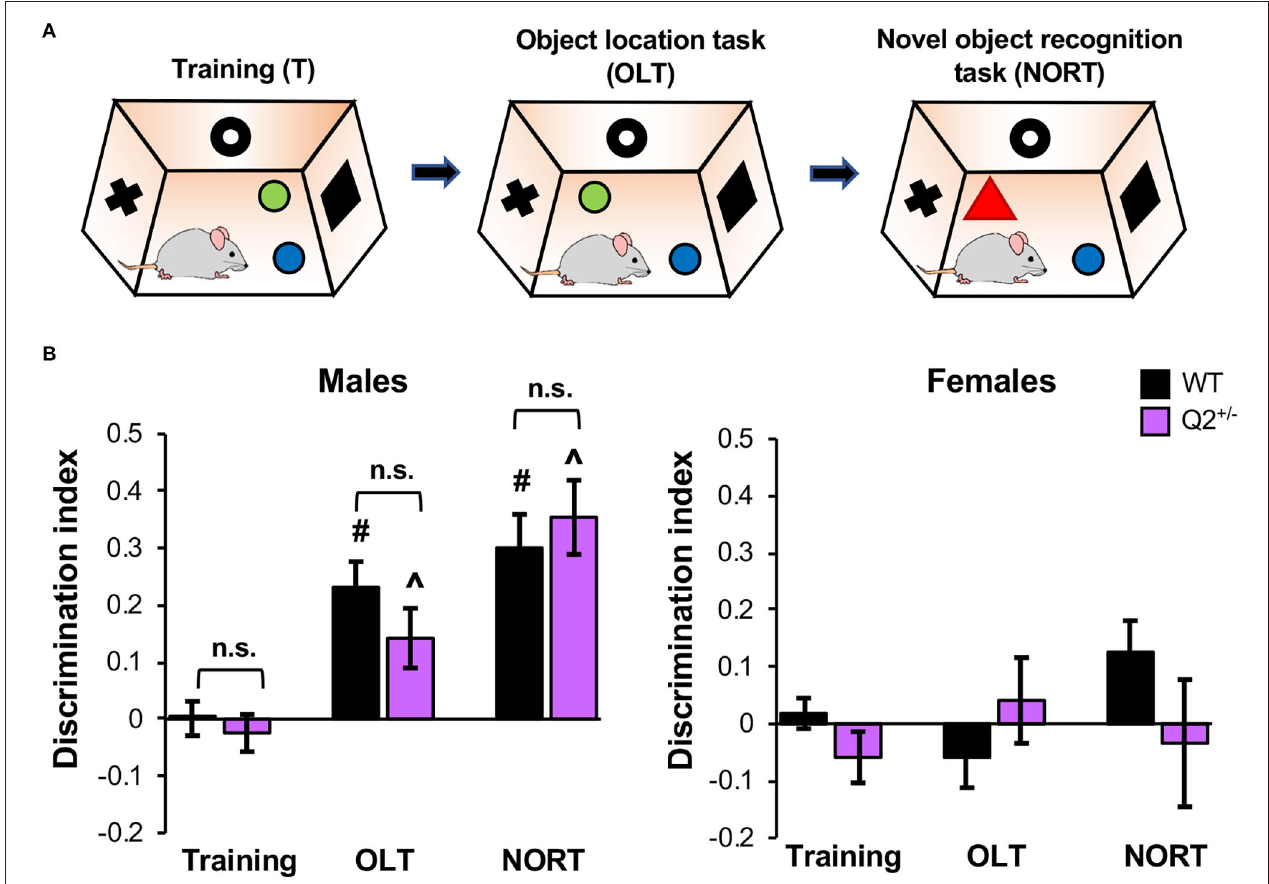
FIGURE 3 | Heterozygous loss of Potassium Voltage-Gated Channel Subfamily Q Member 2 ( KCNQ2 ) does not affect object location and recognition memory in male mice. KCNQ2 + / + (wild-type; WT) mice and KCNQ2 + / − (Q2 + / − ) mice at age 4–6 months were subjected to the object location task (OLT) and novel object recognition task (NORT). (A) The design of the OLT and NORT. (B) Discrimination index (DI) of male mice during OLT and NORT. During OLT and NORT, positive DI indicates the preference for the novel object or location, negative score equals preference for a familiar object or location, and zero score indicates no preference. The number of mice used: male mice (WT = 14, Q2 + / − = 8), female mice (WT = 12, Q2 + / − = 7). Data represent the mean ± SEM. Post-hoc Tukey test results are shown for training vs. OLT or training vs. NORT for WT male mice ( # p < 0.001) and for Q2 + / − male mice ( ∧ p < 0.001). The individual data points are shown in Supplementary Figure S3